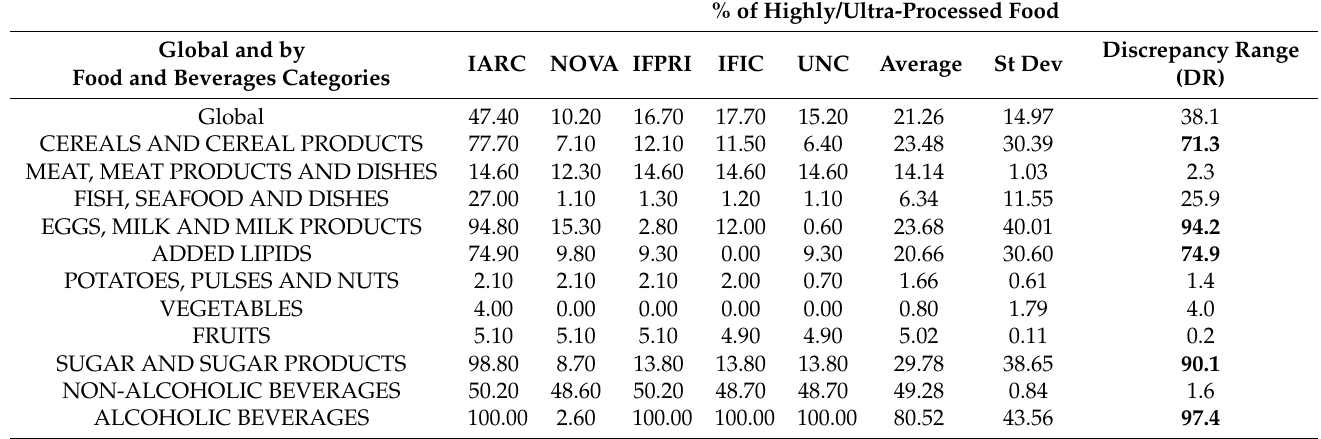
Table 3. Contribution of highly/ultra-processed food and beverages according to different classification systems: global and by food and beverages categories—Portuguese household budget survey, 2000.